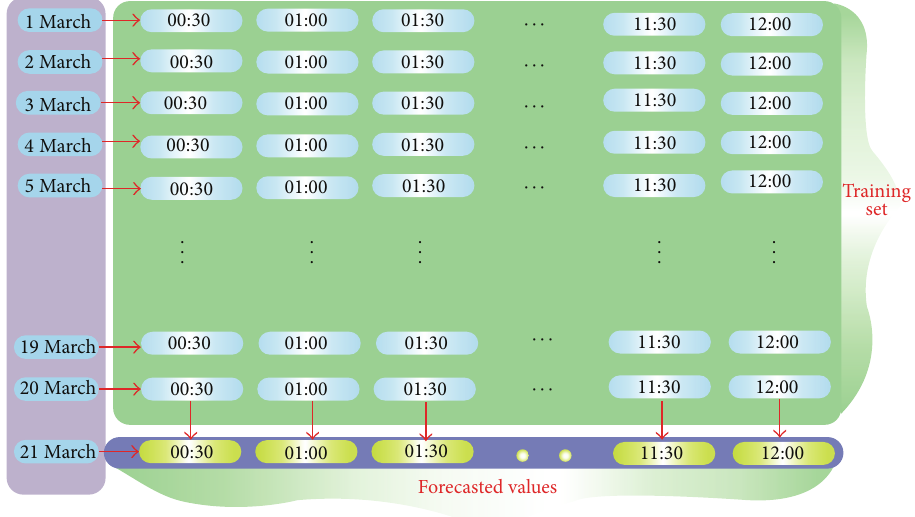
Figure 6: Simulation process description.